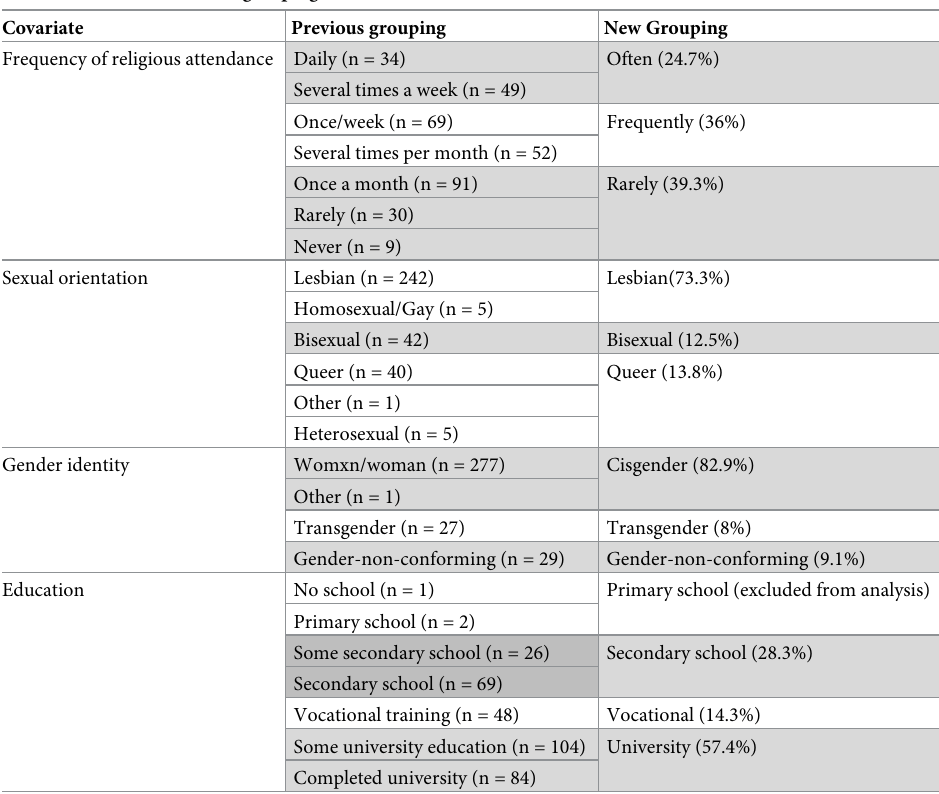
Table 3. Covariates and new groupings.